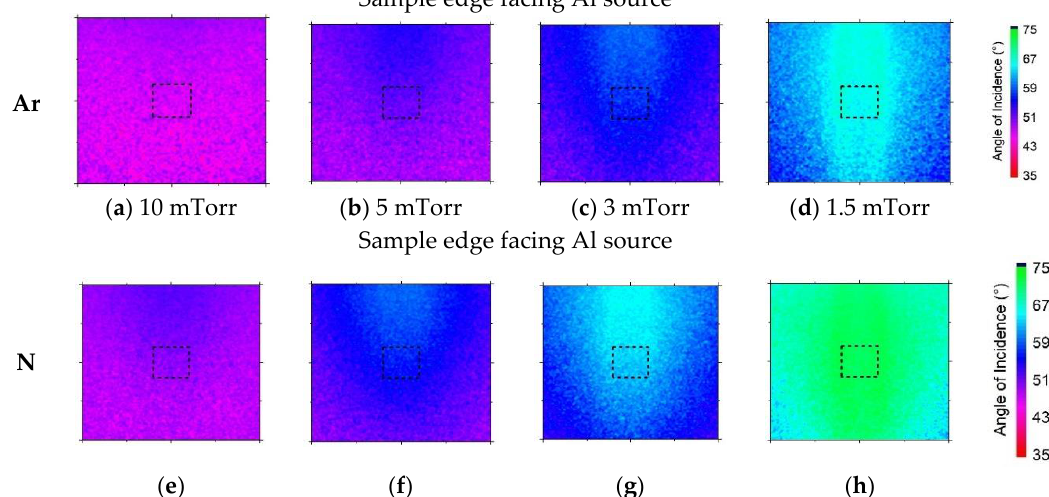
Figure 9. Simulations showing average α of incoming metal flux when Al is sputtered using Ar (top) and N (bottom) at 10 ( a , e ), 5 ( b , f ), 3 ( c , g ), and 1.5 ( d , h ) mTorr working pressures in GLAD configuration. The dashed-line square in the maps represents position and (1 × 1 cm 2 ) dimensions of the substrate while the gradient map represents a 5 × 5 cm 2 area to visualize the behavior of transport of metal flux to and around the substrate. The maps are oriented such that the top edge of the map faces the Al source (not shown) placed 12 cm away from the dashed-line square (substrate).